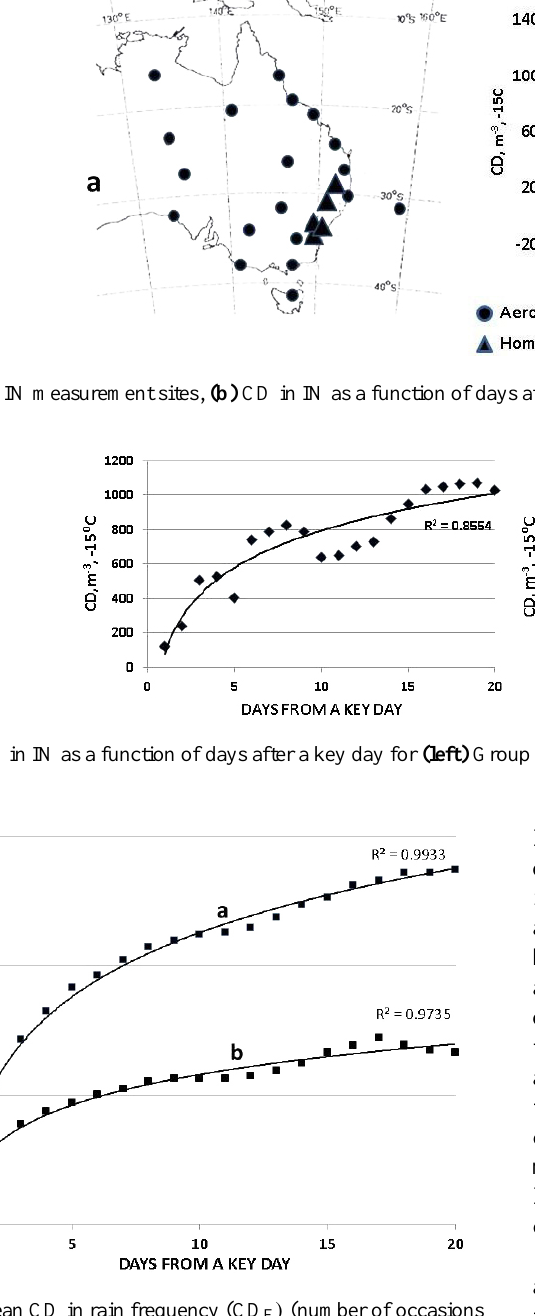
Figure 4. Mean CD in rain frequency (CD F ) (number of occasions of rain>0mm) (a) for 22% of southeastern sites, (b) for 60% of southwestern